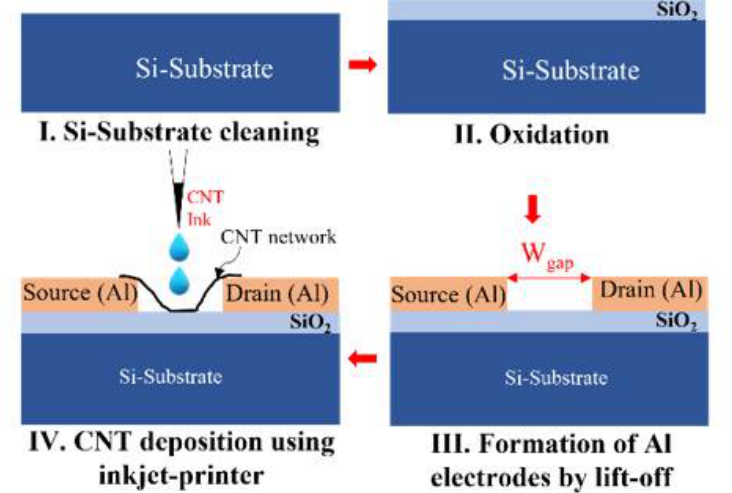
Figure 1. Process flow of the CNT-FET fabrication with inkjet-printed CNTs deposited in between Al source and drain. (I) Preparing the silicon wafer by cleaning. (II) Dry oxidation for the growth of a SiO 2 layer (approx. thickness of 30 nm). (III) Preparing by a lift-off process the source and drain electrodes (defined in Al, approx. thickness of 70 nm) with gaps of different widths, W gap . (IV) CNT printing for deposition in between the source and drain electrodes.